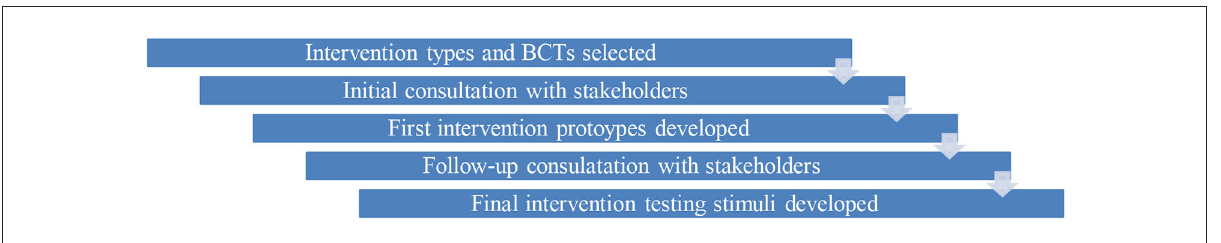
FIGURE6 Steps taken to develop content and implementation